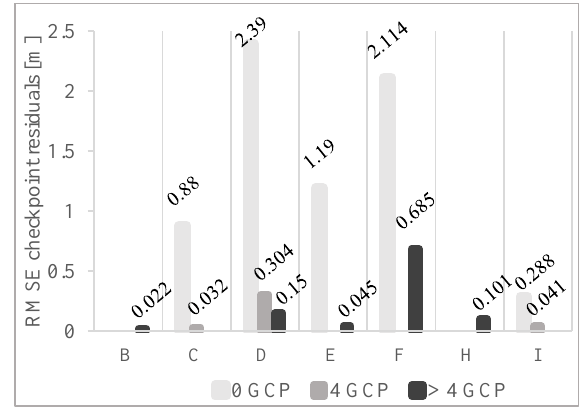
Figure 5: RMSE of different UAV flight missions distinguished by various numbers of GCPs applied to the image